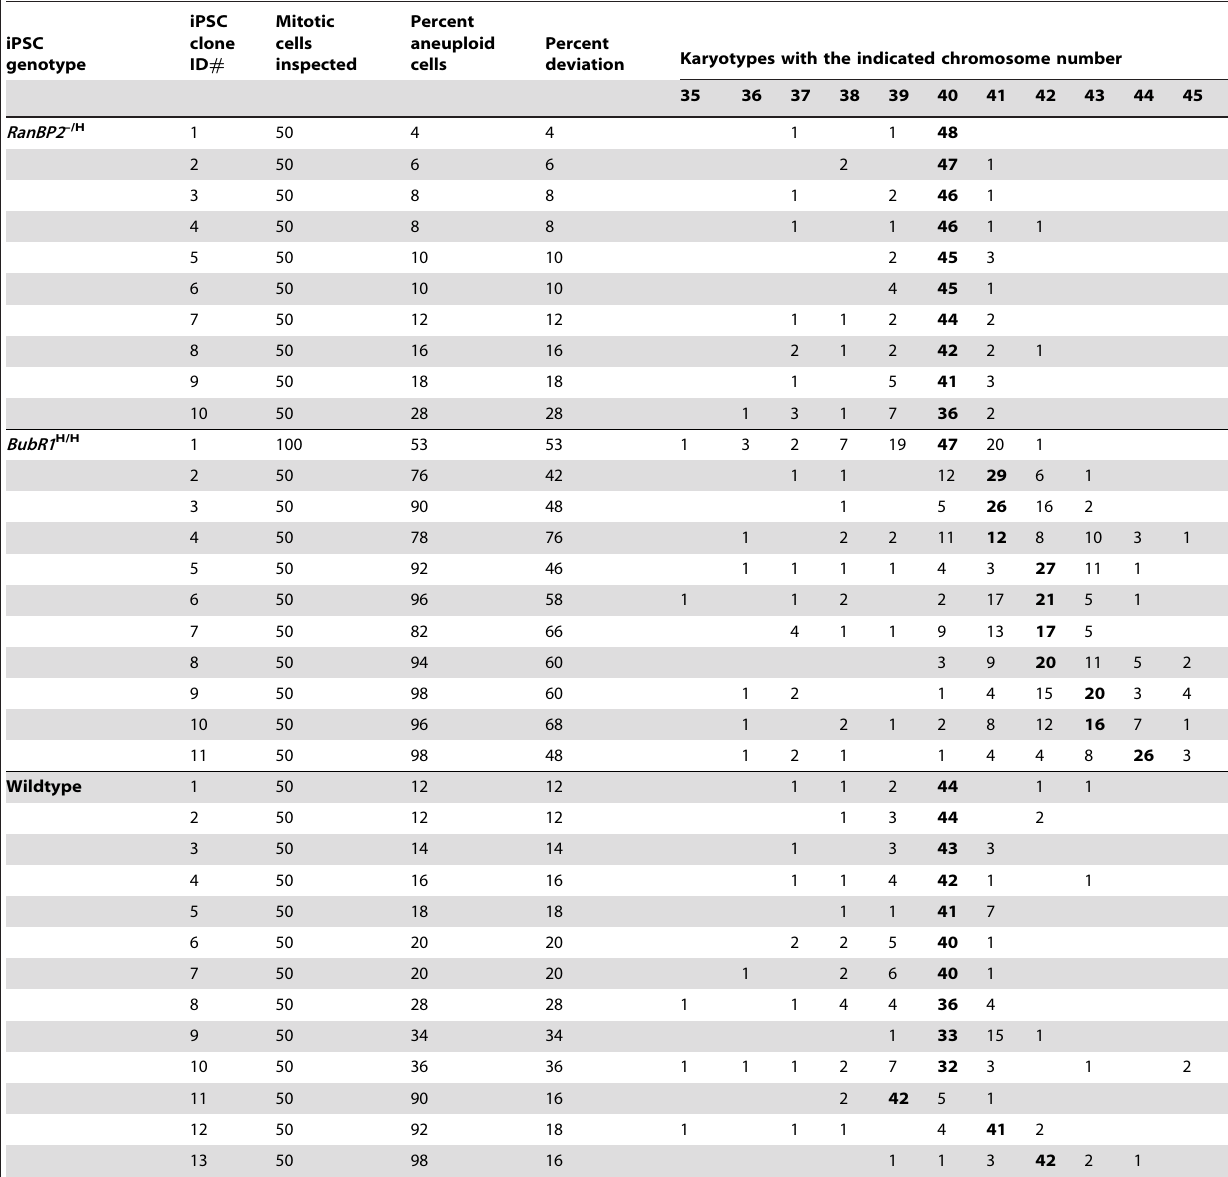
Table 2. W-CIN gene defects do not preclude somatic cell reprogramming.